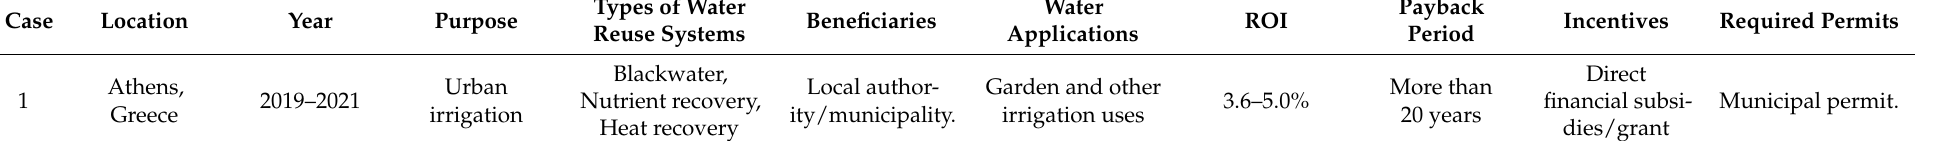
Table 3. Summary of survey results from the demo